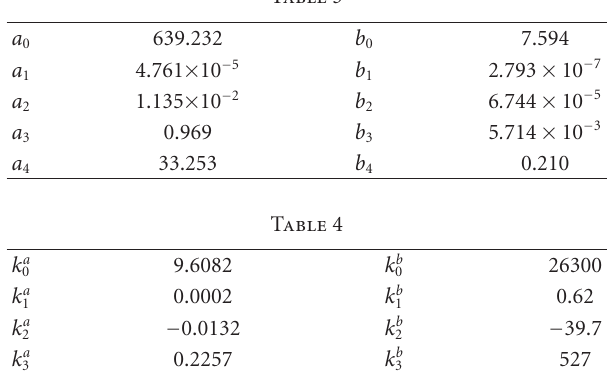
Figure 10: Modelled reformate composition e ff ect on anode performance at 150 ◦ C.